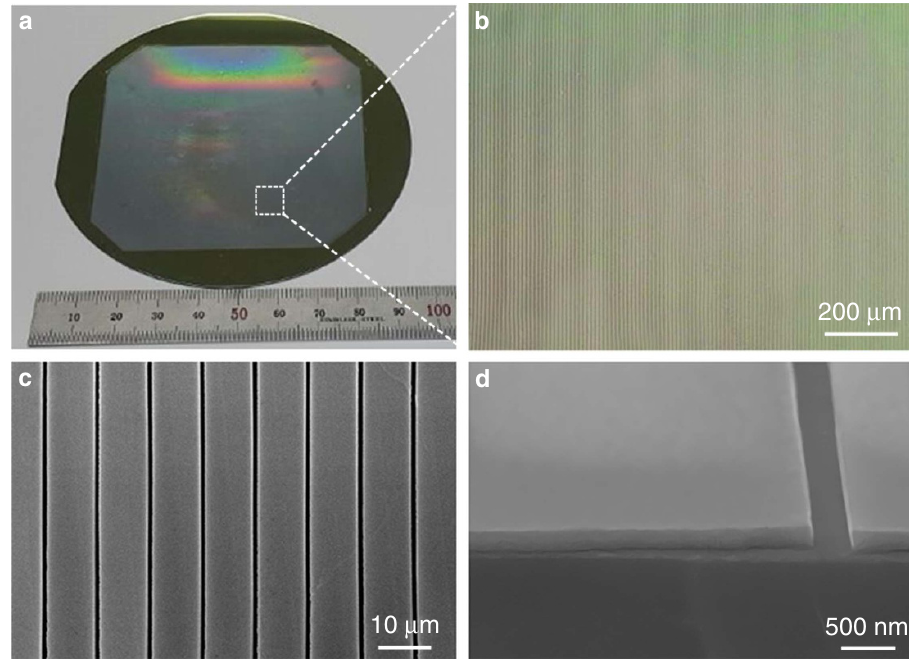
Figure 2 | Wafer-scale single-crystal perovskite thin films. ( a ) Photographic image of the 3 (cid:2) 3 inch perovskite thin films fabricated on a 4-inch, thermally oxidized Si substrate by the geometrically confined lateral crystal growth (GC-LCG) process. ( b ) Optical microscopic image of the perfectly aligned perovskite patterned thin films. ( c ) Scanning electron microscopic (SEM) image of single-crystal perovskite patterned thin film consisting of 10- m m-wide strips with 400-nm-wide spacing. ( d ) Cross-sectional SEM image of 200-nm-thick perovskite single-crystal strips, showing sharp edges and smooth morphology.